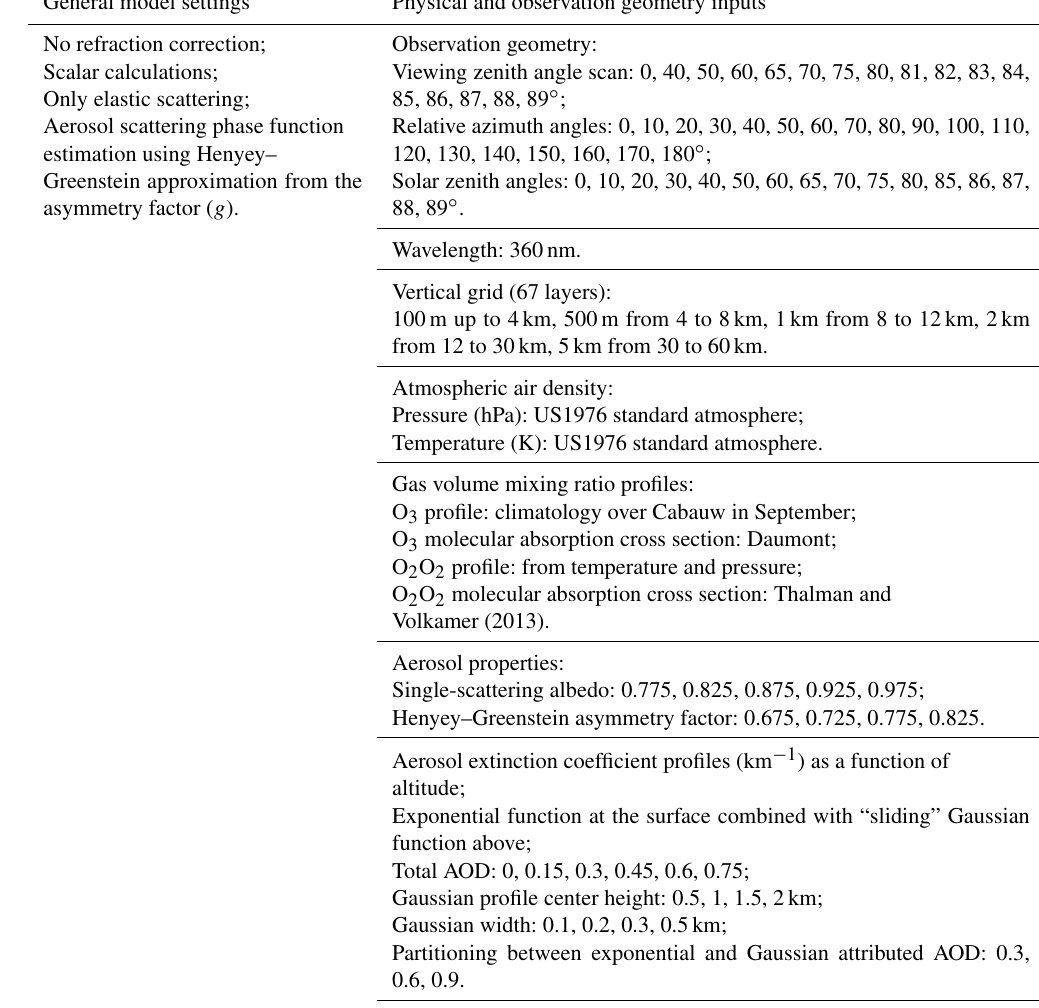
Table 1. Radiative transfer model settings. General model settings Physical and observation geometry